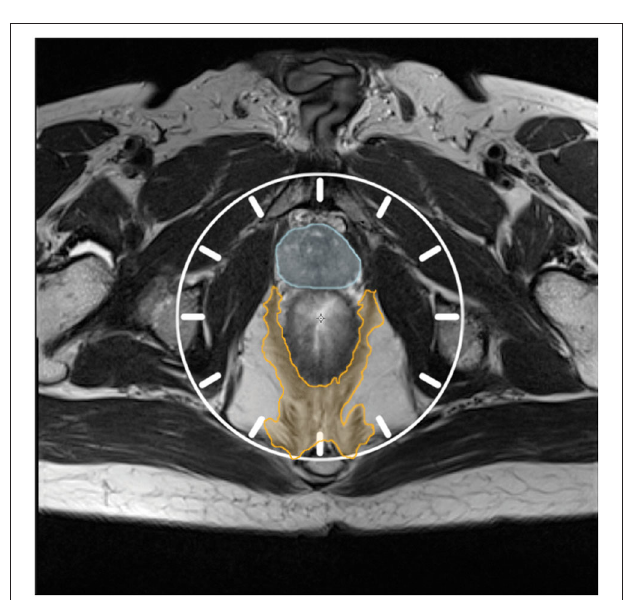
FIGURE 3 | Visualizing the axial plane of T2w MRI as the face of a clock. Orange hatching: Pelvic diaphragm. Blue hatching: Prostate.